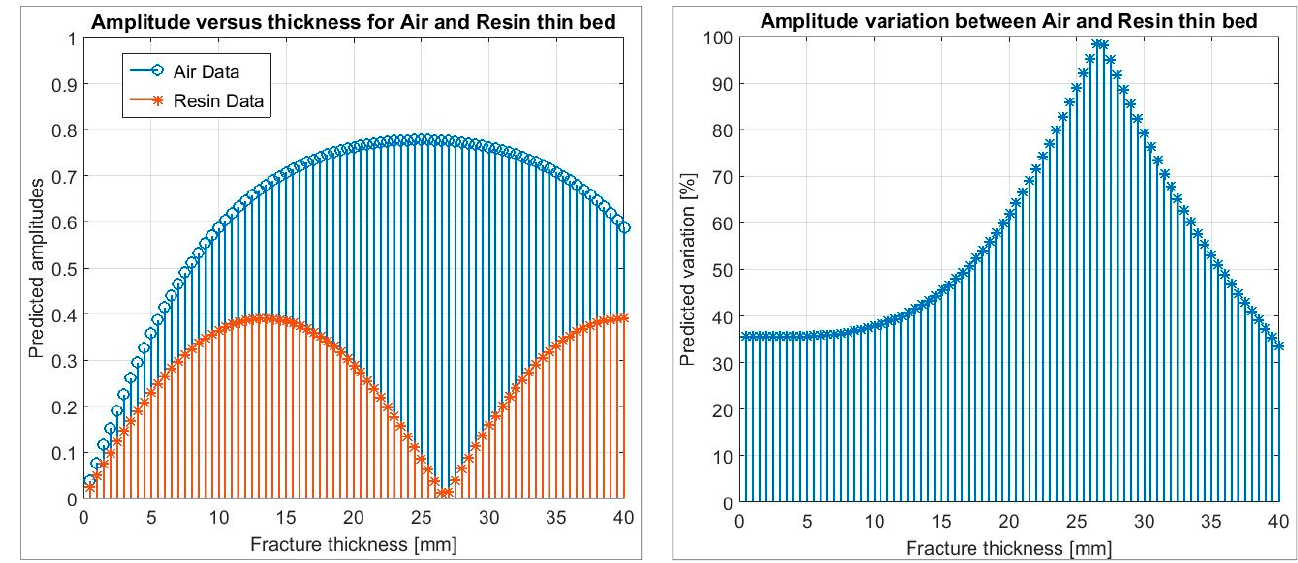
Figure 7. Comparison of the predicted amplitudes for the air-filled fractures versus the resin-filled fractures with a 3 GHz antenna. Circles: air data, Stars: resin data.